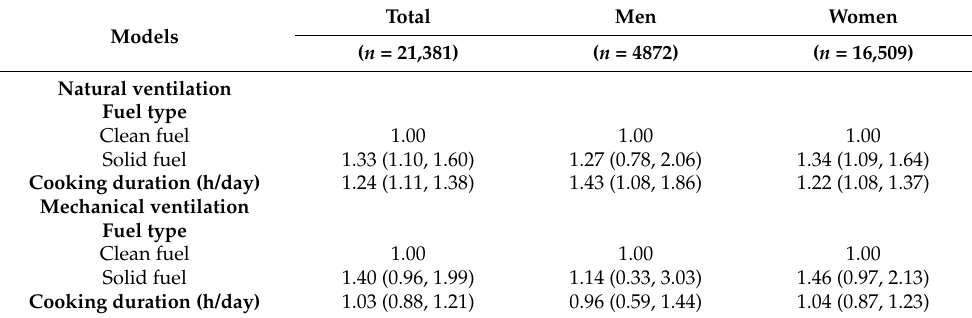
Table 3. Associations of fuel type and cooking duration with suicidal ideation stratified by